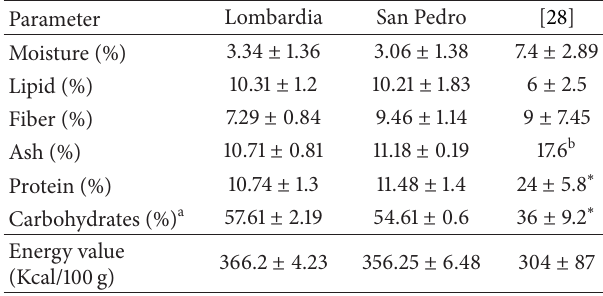
Table 1: Nutritional composition of dried M. oleifera leaf powder.